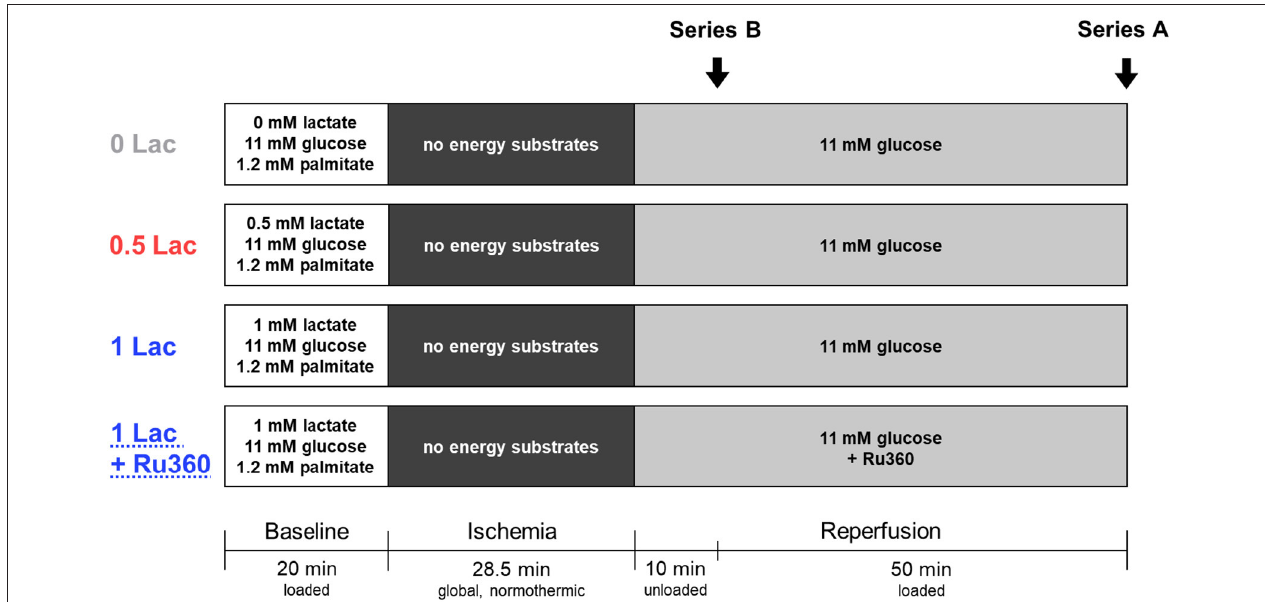
FIGURE 1 | Experimental protocol. Series A: Hearts underwent 20min of baseline working-mode (loaded) perfusion, followed by 28.5min of warm, global ischemia, and 60min of reperfusion [10min unloaded followed by 50 min working-mode (loaded)]. In addition to 11mM glucose and 1.2mM palmitate, three pre-ischemic (baseline) lactate levels were tested: no lactate (0 Lac), physiologic lactate (0.5mM; 0.5 Lac), or DCD-relevant lactate (1mM; 1 Lac). In a fourth group, hearts with DCD-relevant pre-ischemic lactate levels were treated with a mitochondrial calcium uniporter inhibitor, Ru360, during reperfusion (1 Lac + Ru360). Series B: The same four experimental groups were used, but perfusions were stopped after 10min of reperfusion in order to isolate mitochondria.